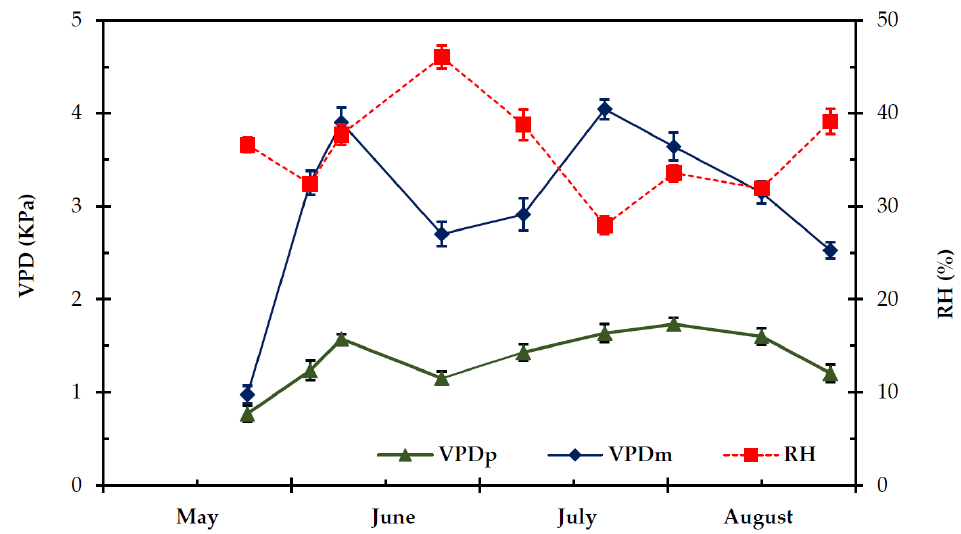
Figure 1. Seasonal predawn (VPD p ) and midday (VPD m ) vapour pressure deficit and relative humidity (RH) in the study site, during the experimental period, from 27 May to 28 August. The values are means ± SE ( n = 24).